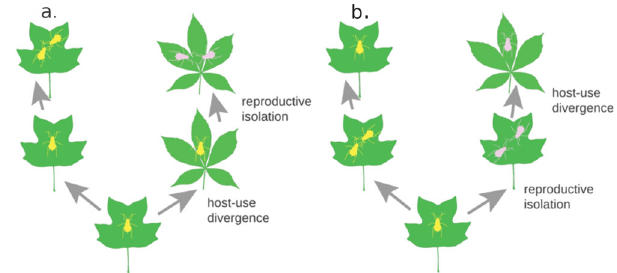
Fig. 1 Competing hypotheses for the role of host-use evolution in herbivorous insect diversi fi cation. a Host-use divergence leads to the evolution of reproductive isolate, hence evolutionary antagonism is the main driver of speciation. b Host-divergence follows the evolution of reproductive isolation, and raises the ecological limits on species